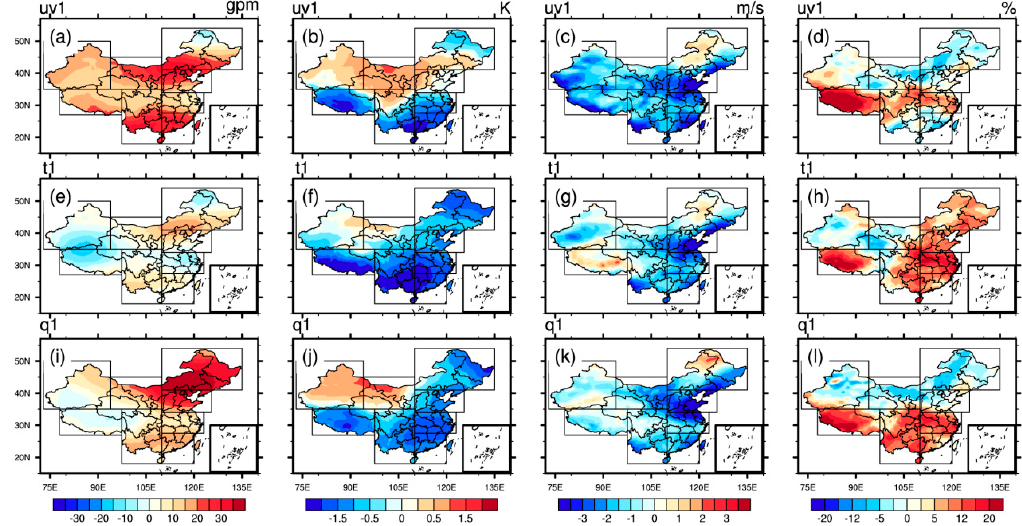
Figure 3. Same as Figure 2, but for meteorological elements at 500 hPa, including: geopotential height ( a , e , i ); temperature ( b , f , j ); wind speed ( c , g , k ); and relative humidity ( d , h , l ).